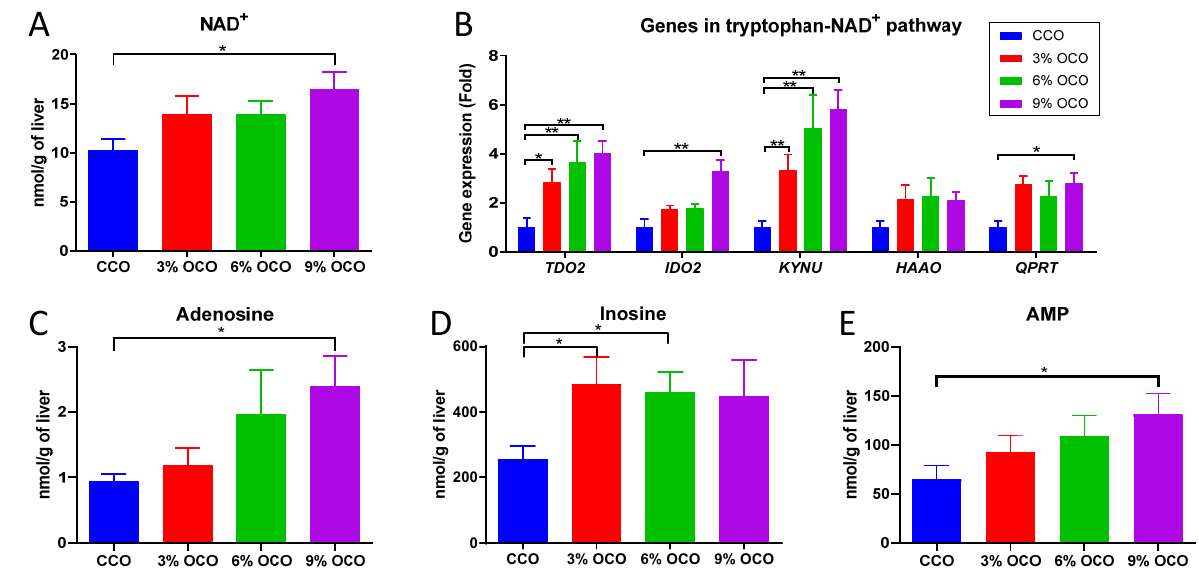
Figure 4. Effects of dietary concentration of oxidized corn oil (OCO) on the concentrations of metabolites and the levels of gene expression in the hepatic tryptophan-NAD + pathway. ( A ) NAD + . ( B ) Gene expression levels of the enzymes in kynurenine pathway. The average gene expression level of control corn oil (CCO) liver samples was artificially set as 1. ( C ) Adenosine. ( D ) Inosine. ( E ) AMP. Value = mean ± SEM (n = 8 pigs/group). * p < 0.05 and ** p < 0.01 from one-way ANOVA